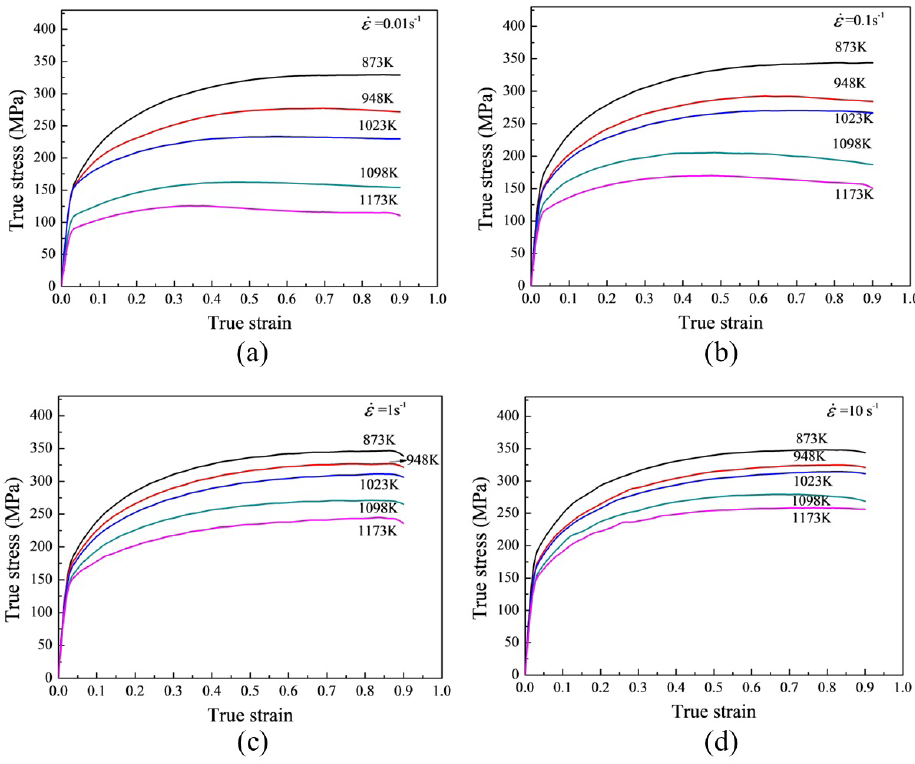
Figure 1. The true stress-strain curves of Invar36 alloy under the different temperature with strain rates of (a) 0.01 s -1 , (b) 0.1 s -1 , (c) 1 s -1 and (d) 10 s -1 .